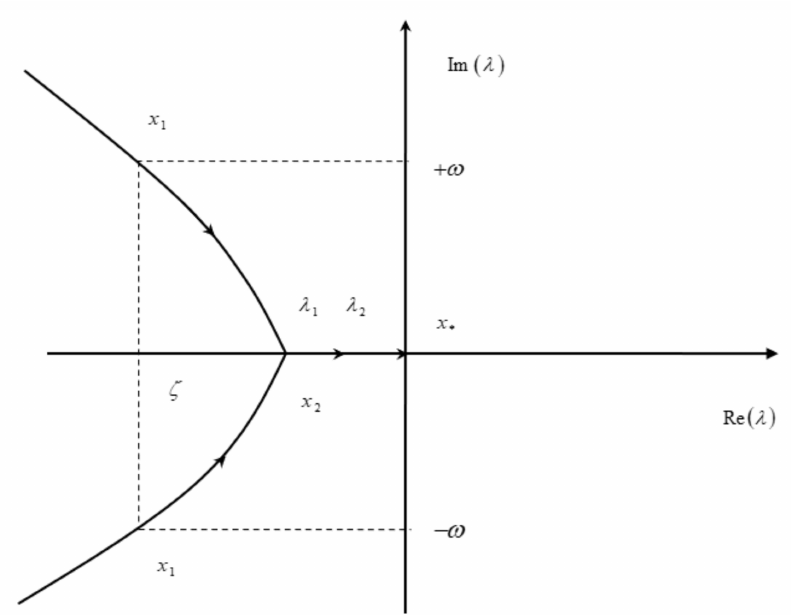
Figure 11. Manouever points of the second kind for oscillatory modes becoming monotonic modes (convergent or divergent) before zero